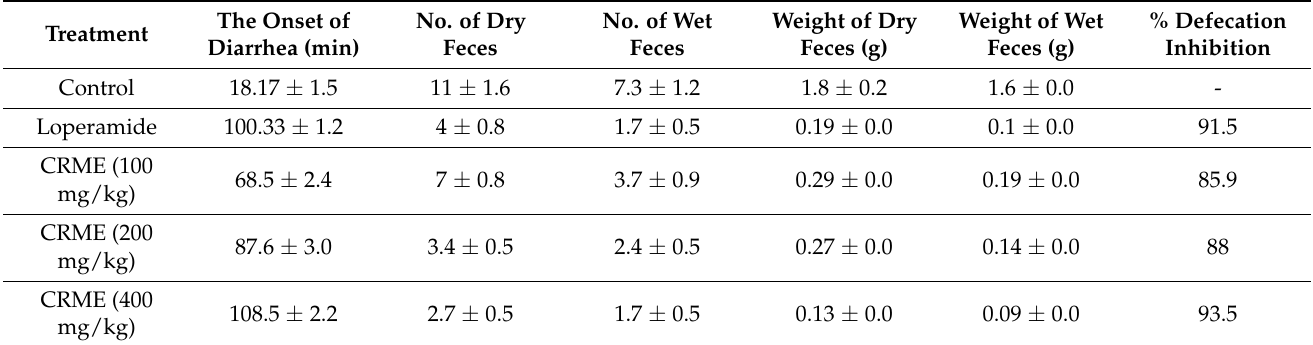
Table 5. Antidiarrheal effect of CRME (results expressed as mean ± SD).